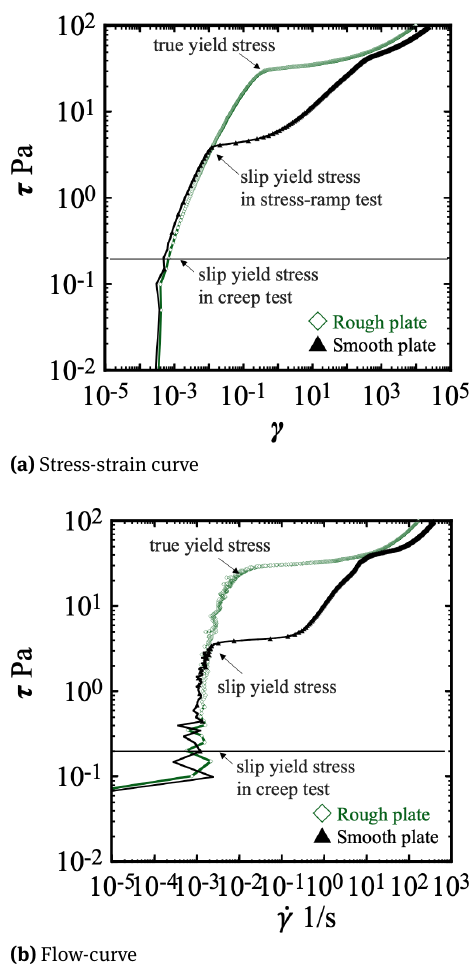
Figure 3: (a) Stress-strain curve and (b) flow-curve, were obtained from a stress-ramp test with a ramp rate of 0.5 Pa/s for plates with different surface roughness. Below the slip yield stress, the slopes for the rough and smooth plates are coherent